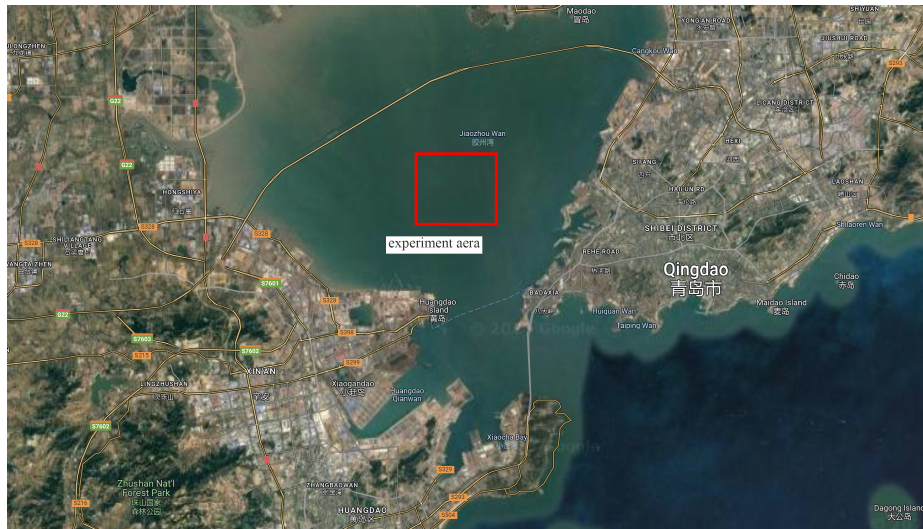
Figure 11. Experiment area in Qingdao,